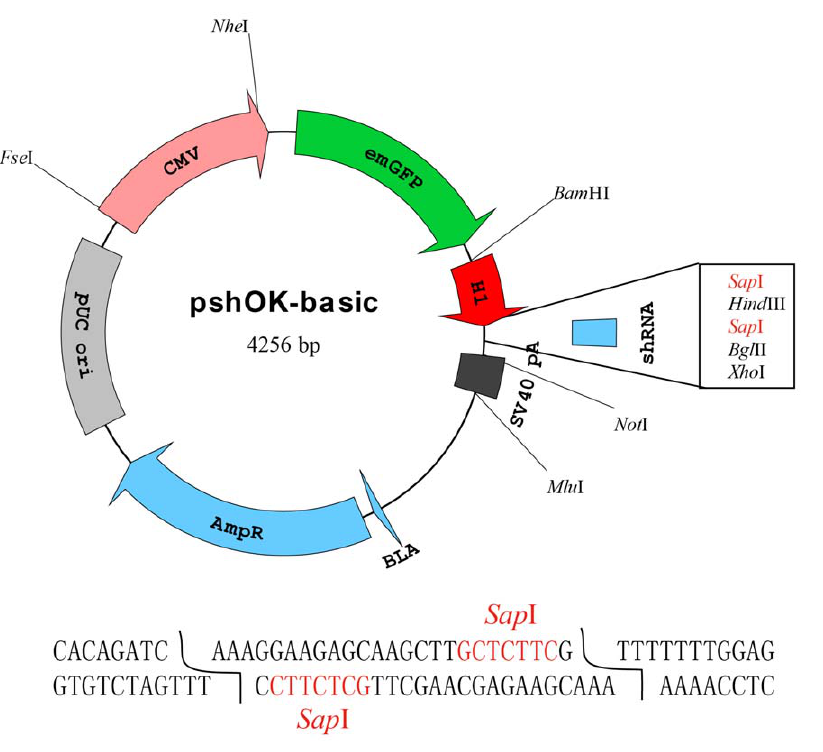
Figure 1. The pshOK-basic plasmid map for generation of shRNAs. The modified H1 promoter containing an AAA terminus followed by 2 Sap I restriction sites and 7 polyTs was used to introduce and express shRNAs. Upstream of the H1 promoter, the CMV-emGFP unit was used to tract shRNA expression. The isoaudamers Bam HI and Bgl II restriction sites were inserted as a means of generating linked shRNAs.